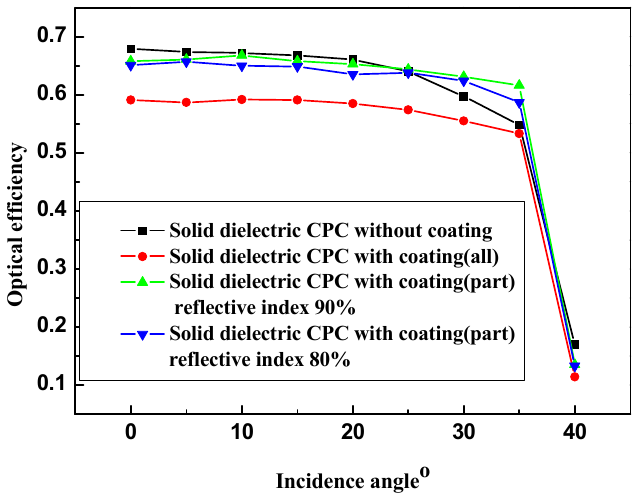
Figure 12. Comparison of optical efficiencies of the truncated solid CPC without mirror coating, with full or partial coating,